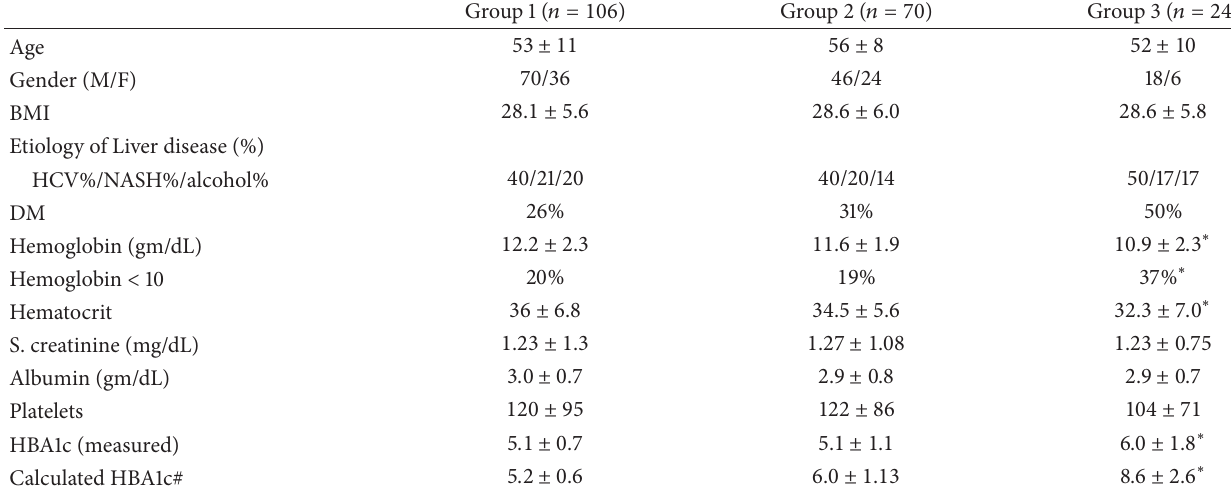
Table 1: The characteristics of the groups based on difference between the calculated and measured hemoglobin A1c.